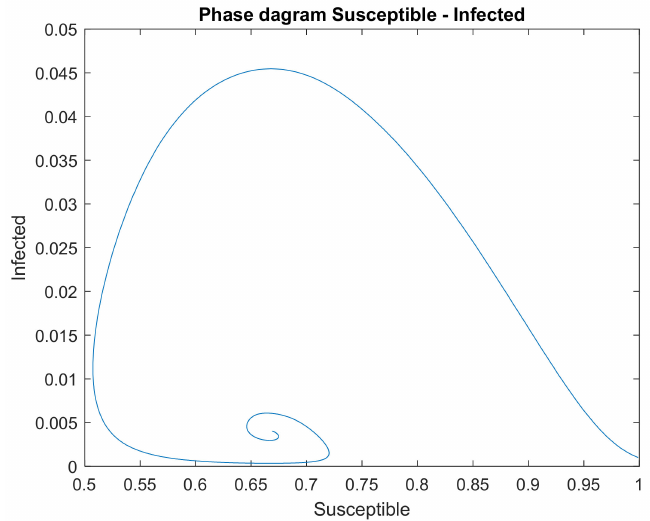
Figure 12. Phase portrait of I against S for the CSIRQ